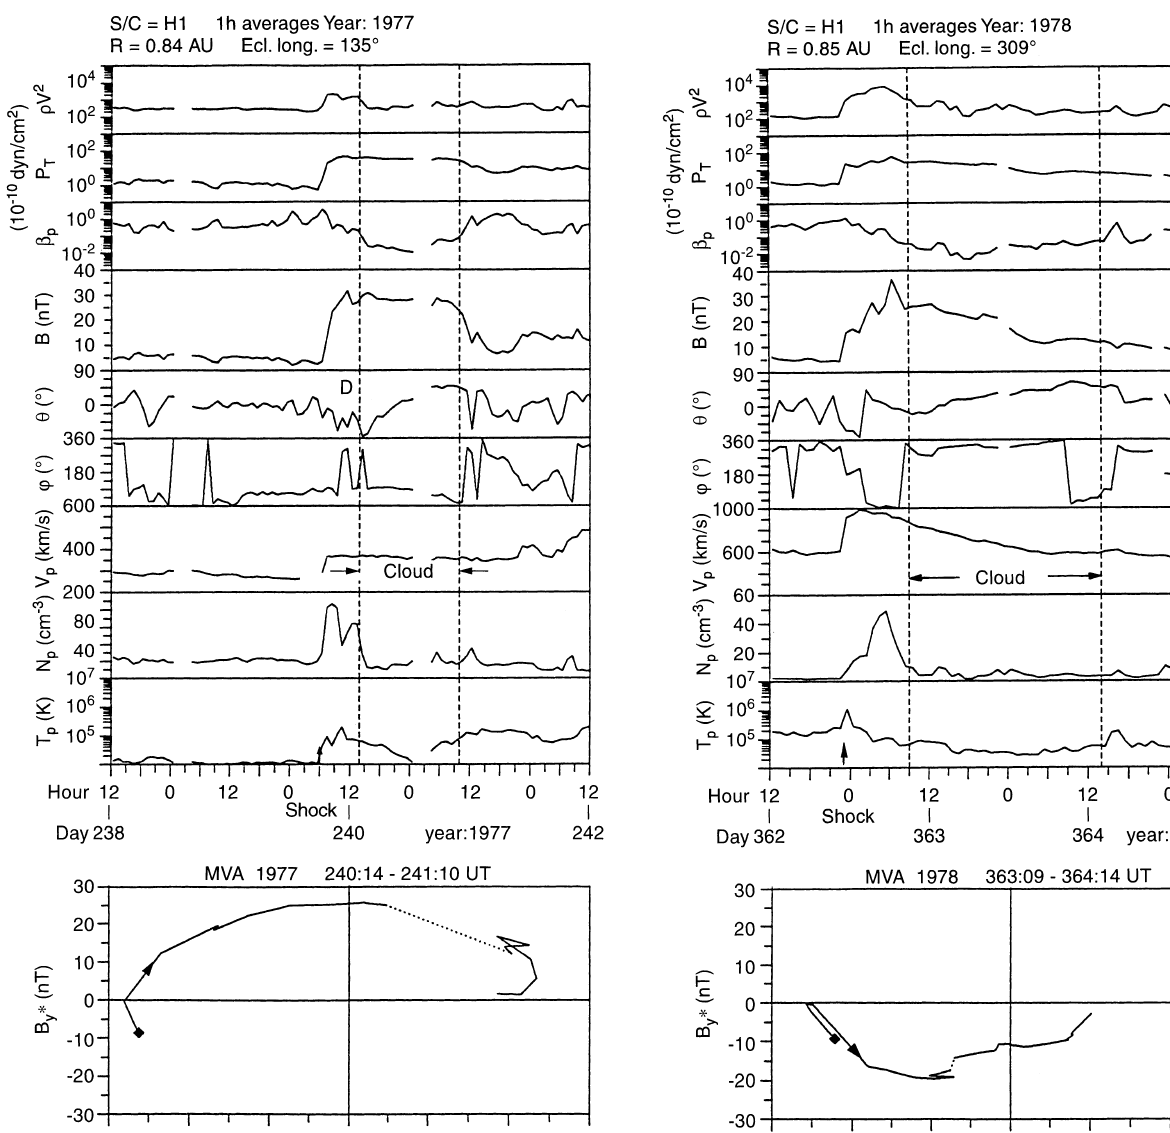
tions at 0 (cid:14) should be 360 times more likely than those at